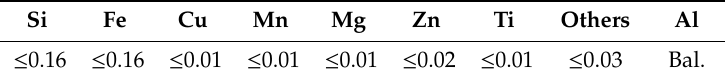
Table 1. Chemical composition of industrial aluminum (mass fraction %).